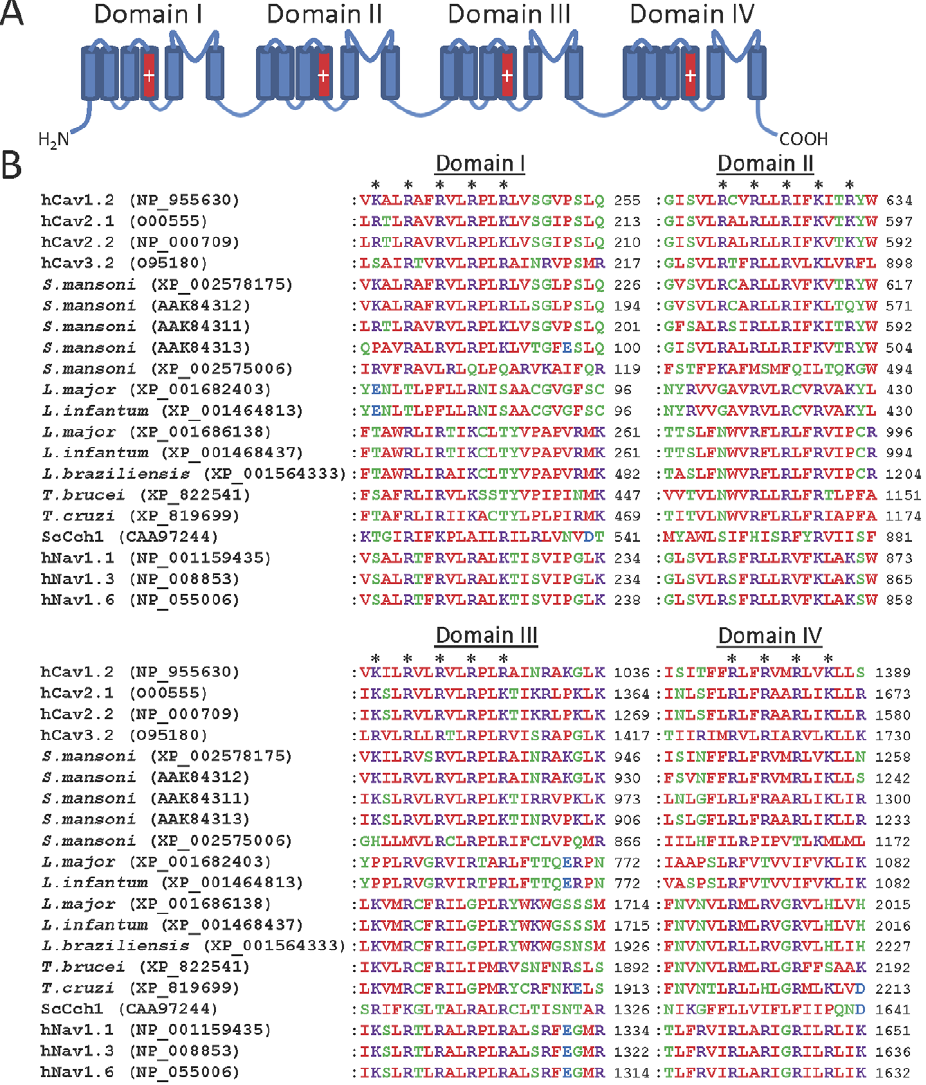
Figure 7. Parasite Ca v channel homologues show similarity to human Ca v channels in the voltage sensor region. (A) Schematic showing the four-domain structure of human Ca v channels, with the voltage sensors of each domain shown in red. (B) Multiple sequence alignments of the voltage sensor domains of human Ca v channels with parasite Ca v channel homologues. Only those parasite homologues containing four putative domains are shown. Asterisks indicate the position of basic residues which form the voltage sensor in each domain of human Ca v 1.2 channels.